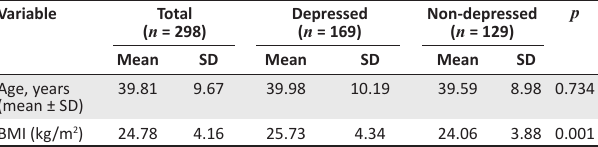
TABLE 1a: Demographic characteristics of the depressed and non-depressed participants.